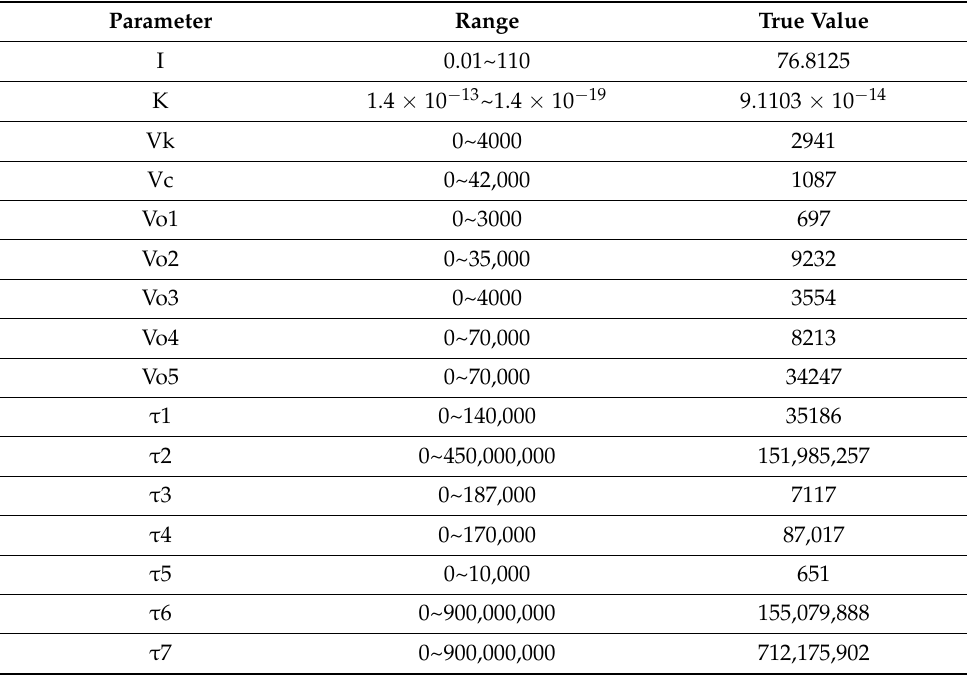
Table 7. The parameters of GA (P brand 18650).